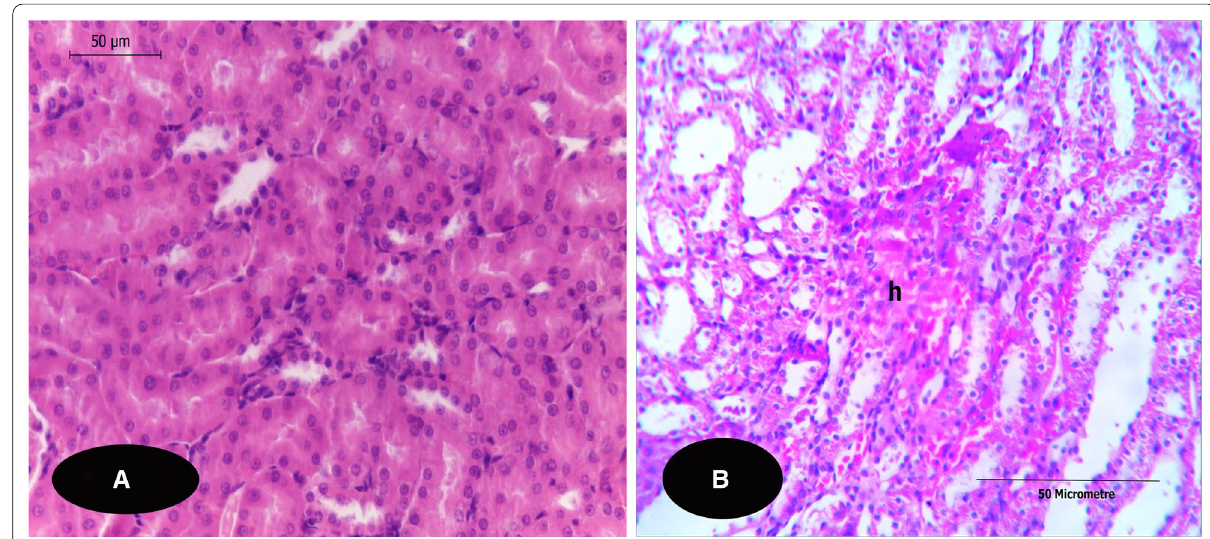
Fig. 6 A , B T. S. of kidneys of rats show parts of the medullae stained with H&E. A T. S. of a kidney of G1 (control rat) showing a typical structures of the medullary tubules. (X 400). B T. S. of a kidney of G4 showing blood congestion/haemorrhage (h) which is detected on the medullary region in of this group (X 100). Notice: both G2&3 did not show any histopathological alterations in the medullary regions of the examined kidney sections